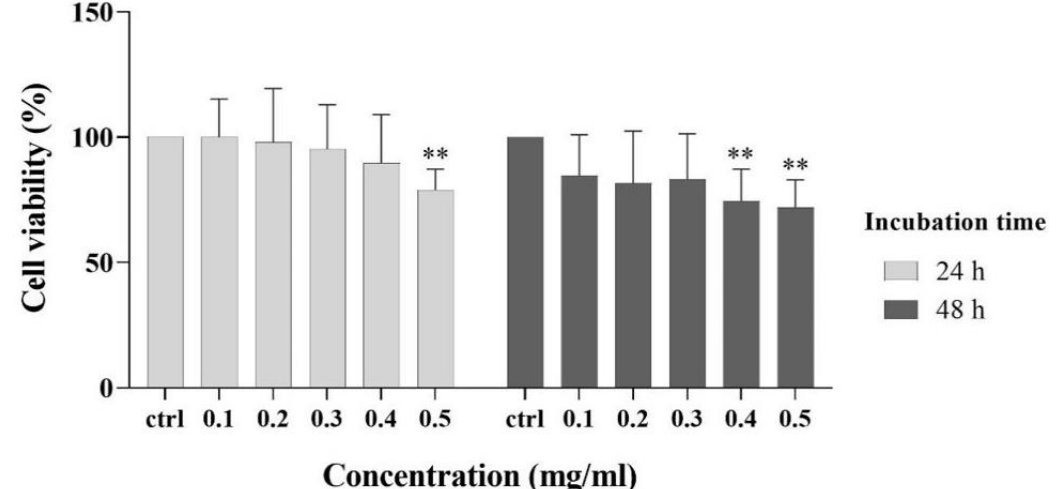
Figure 6. Cell viability using WST-1 assay. HEK-293 cells treated with specific concentrations of AuNPs (0.1–0.5 mg/mL) for 24 h and 48 h. An asterisk indicates a significant difference between the experimental groups and control (using Mann–Whitney test, ** p -value < 0.01).